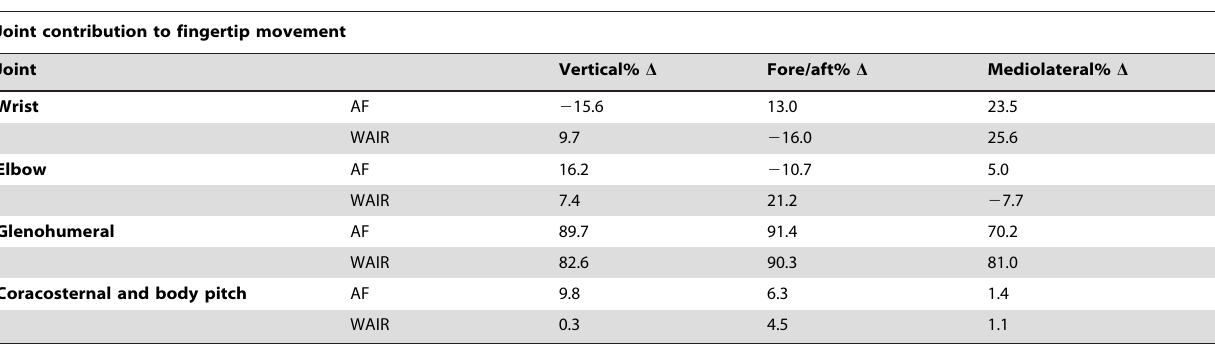
Table 5. Percent change in fingertip motion after removing contributions from subsequent distal-most joint.